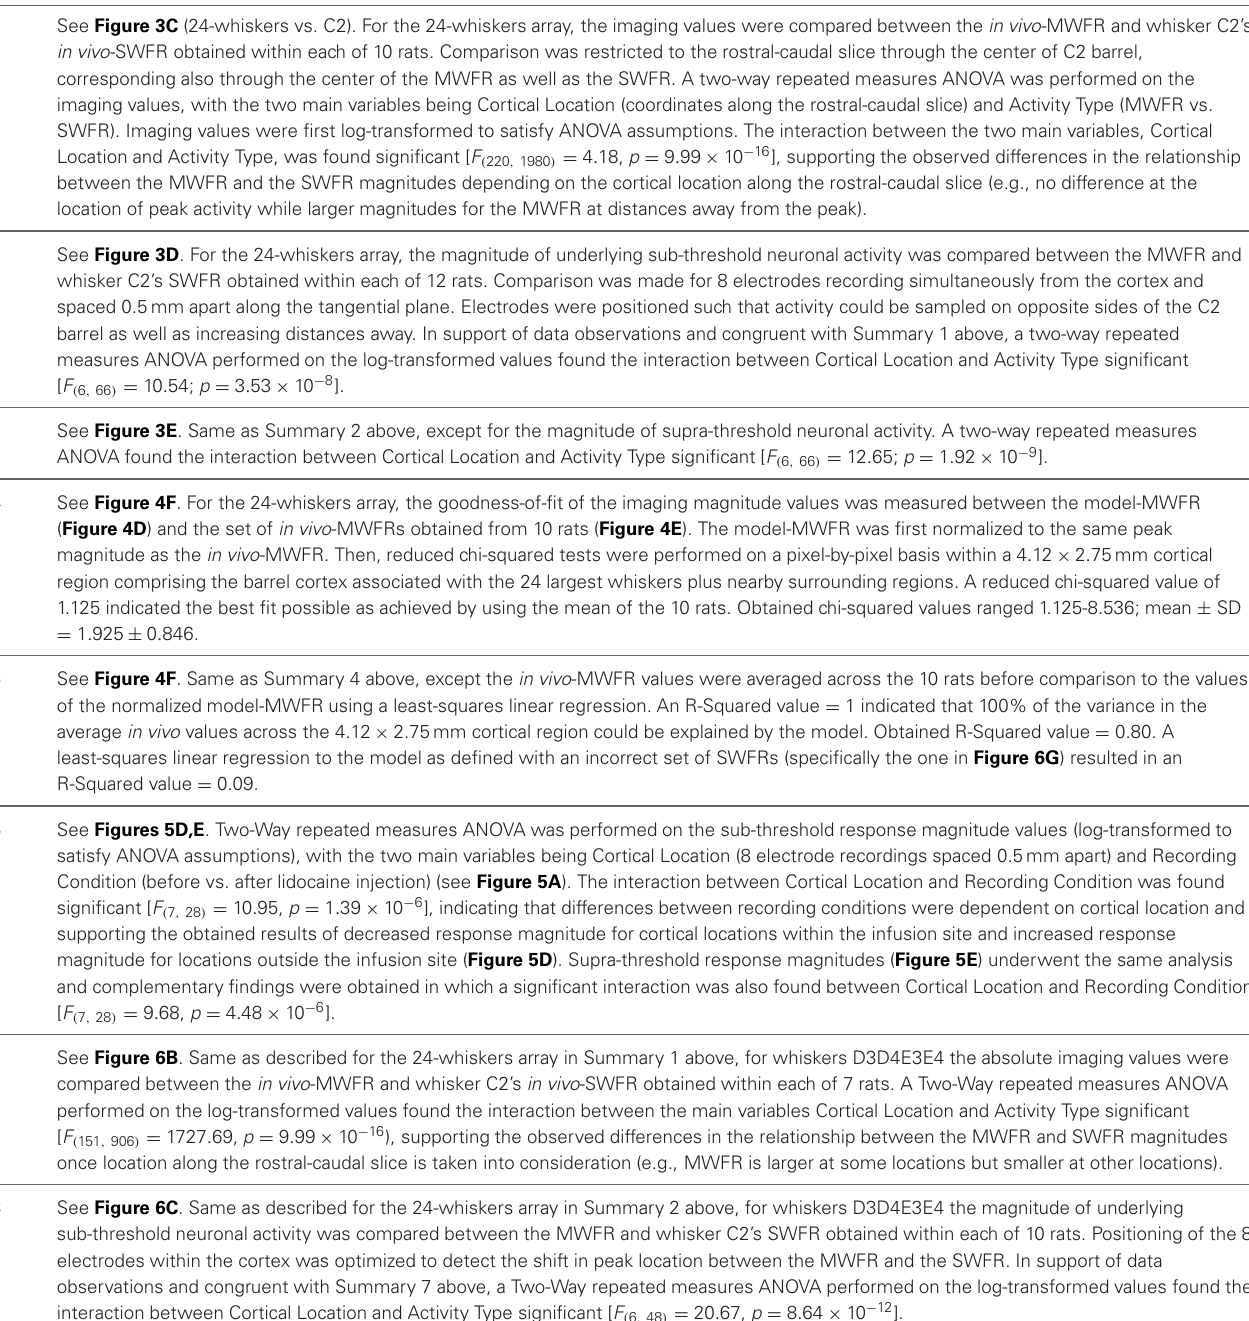
Table 1 | Statistics summaries of multi-whisker functional representation (MWFR) and single whisker functional representation (SWFR)